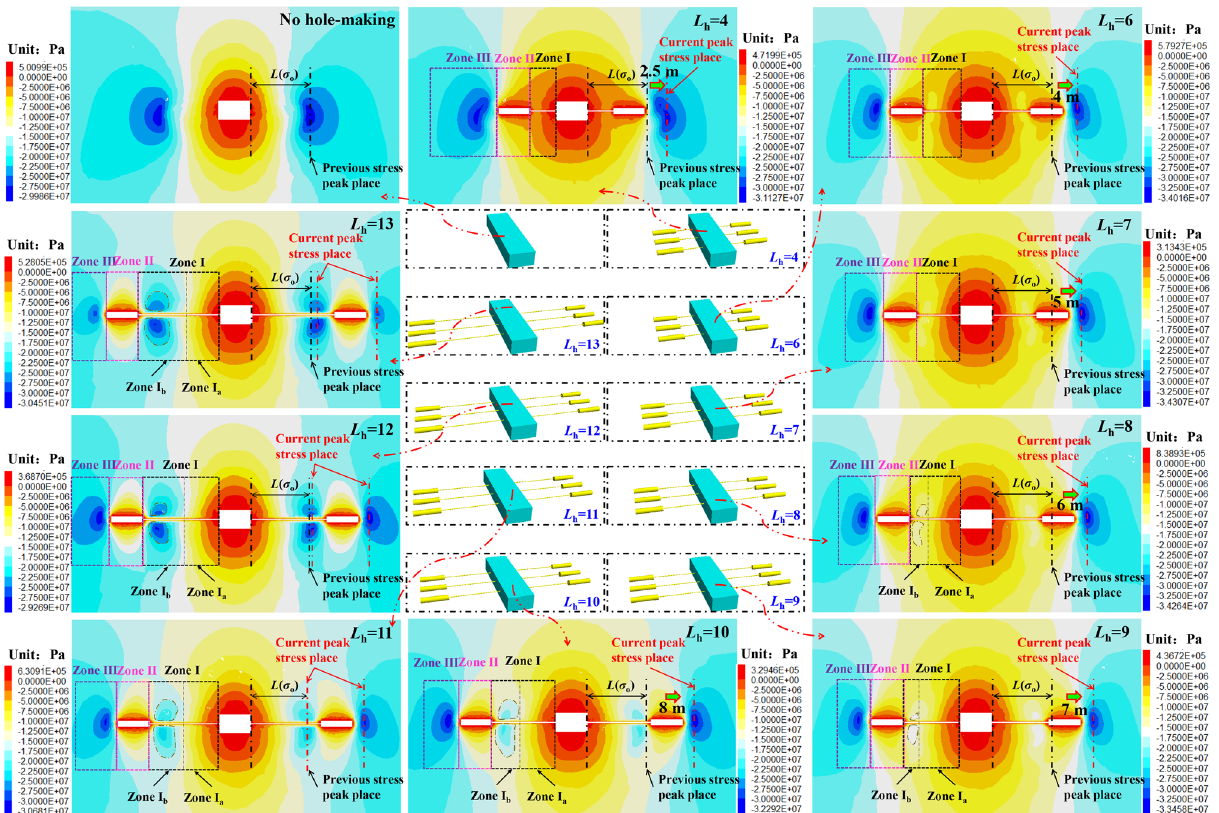
Figure 9. Nephogram of stress distribution of chamber surrounding rock at different L